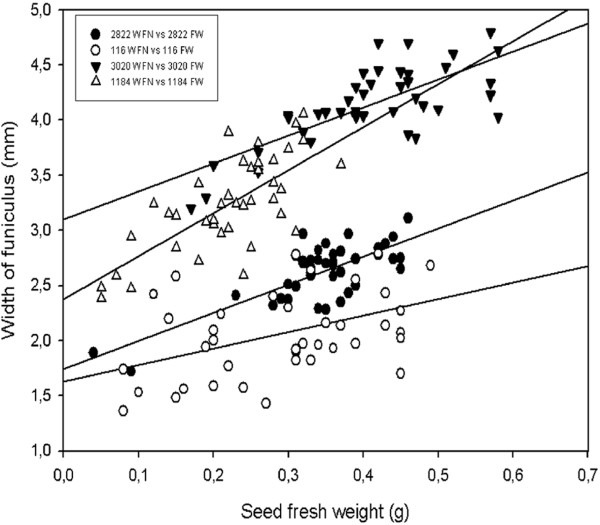
The relationship between seed fresh weight (FW) and width of funiculus (WFN) in the wild type and the def mutant Pisum sativum. Linear models were fitted to four data sets: JI 116 (Y = 1.63 + 1.49 X; R2 = 19.6%; P = 0.000), JI 2822 (Y = 1.74 + 2.55 X; R2 = 57.4%; P = 0.000), JI 1184 (Y = 2.37 + 3.91 X; R2 = 51.7%; P = 0.000), JI 3020 (Y = 3.10 + 2.54 X; R2 = 55.9%; P = 0.000).